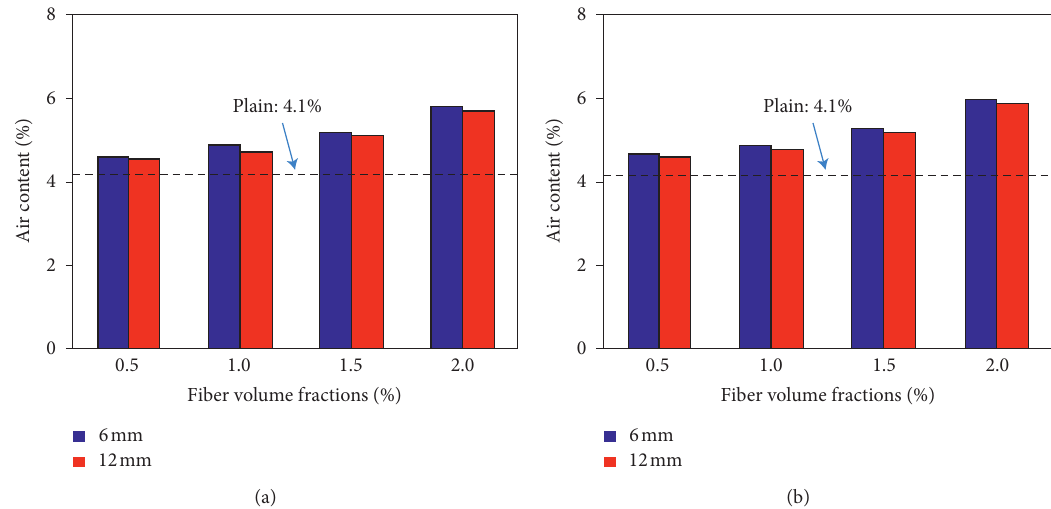
Figure 8: Air content test results with fiber lengths and fiber volume fractions: (a) SiO